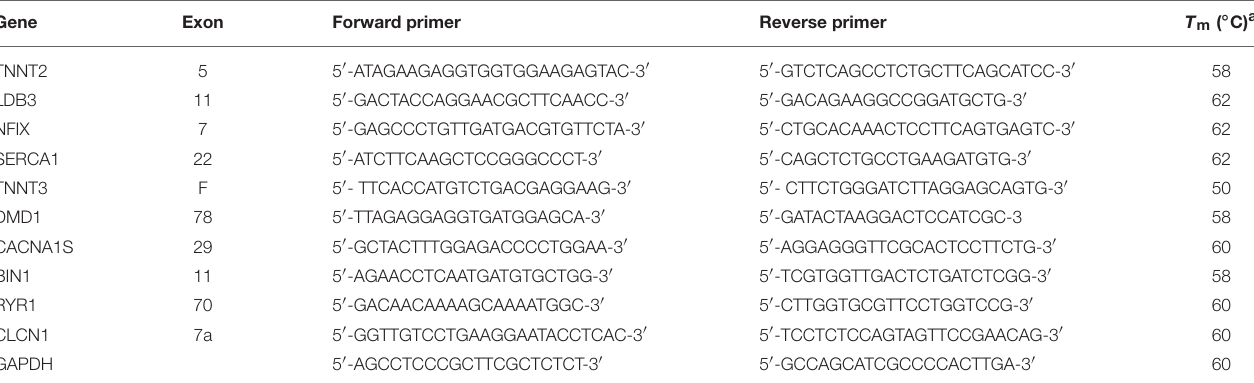
TABLE 1 | List of PCR primers used for splicing analysis for each gene with the relative spliced exon.